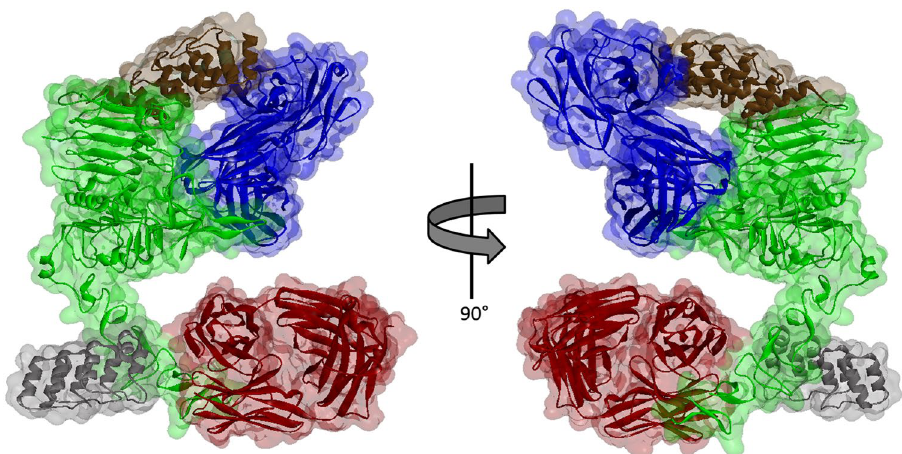
Figure 3. Molecular model of HER2 bound by two antibodies and two DARPins. The extracellular domain of HER2 (green) from four different crystal structures were superimposed to model the spatial proximity between the various binders. Trastuzumab is represented in red (PDB ID 1N8Z), Pertuzumab in blue (PDB ID 1S78), DARPin G3 in gray (PDB ID 4HRN), and DARPin 9.29 in brown (PDB ID Molecular Modeling and Screen to Identify Optimal Antibody Pairs. To achieve TEC, a pair of antibodies binding proximal, but non-overlapping epitopes are required. Numerous antibodies and other binders have been crystallized bound to HER2 and are available in the Protein Data Bank (PDB) 34–39 . We selected four HER2 binders based primarily on their binding of distinct HER2 epitopes by superimposing the HER2 portion of respective crystal structures (Fig. 3, see Supplementary Figure S4 for superimposition of the various crystal structures). The set consists of two antibodies (trastuzumab and pertuzumab) and two Designed Ankyrin Repeat Proteins (DARPins, DARPin G3 and DARPin 9.29). Trastuzumab and pertuzumab are both FDA-approved drugs for the treatment of HER2-positive breast cancer 40, 41 . As evident from the superimposition of their structures,